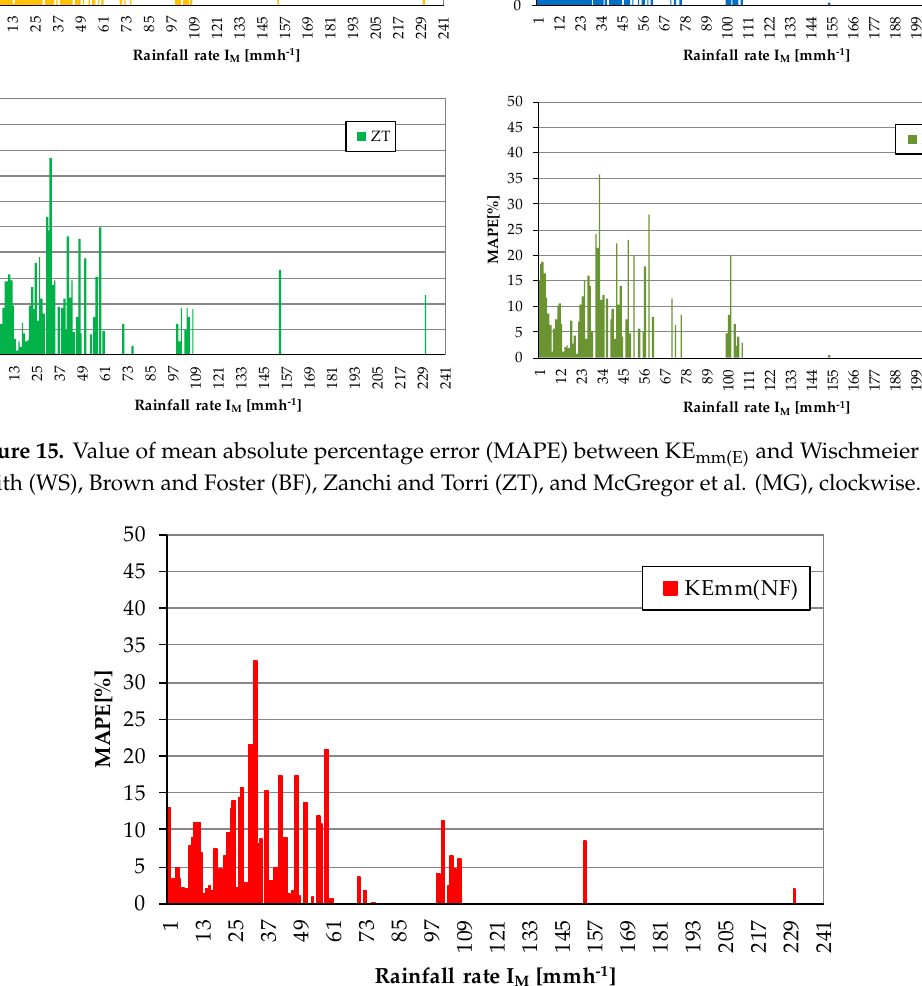
Figure 15. Value of mean absolute percentage error (MAPE) between KE mm(E) and Wischmeier and